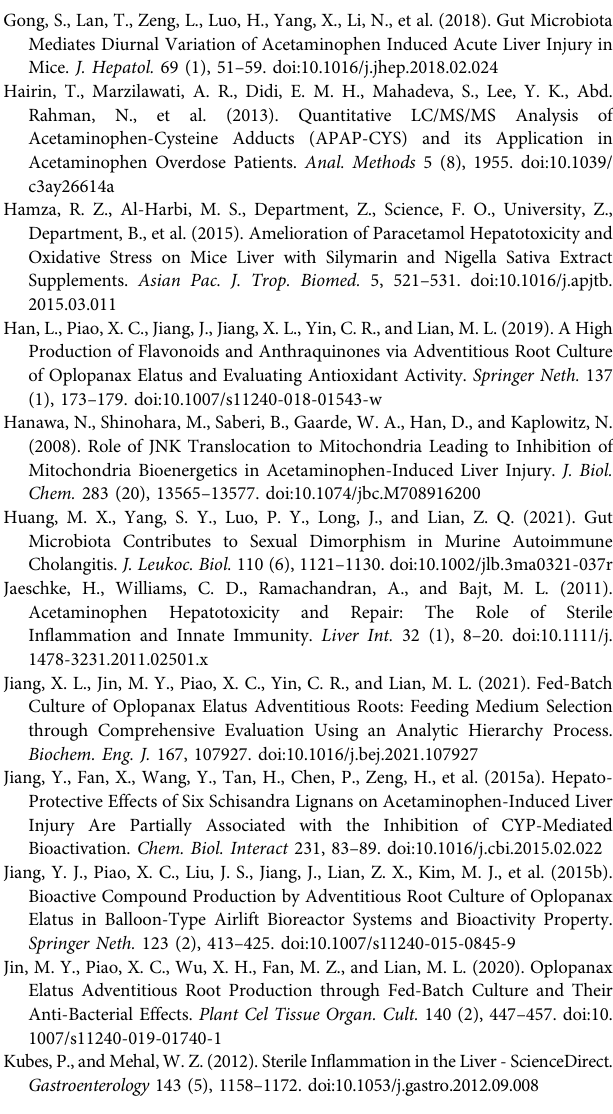
Supplementary Figure S1 | Extraction and separation of active compounds of OEB (A) Extract process of Oplopanax elatus . (B) HPLC pro fi le (UV chromatograms at 208 nm) of OECE, OEA, OEB, and OEC. The main compounds of OEB are chlorogenic acid and isochlorogenic acid A. Chromatography of authentic samples (C) chlorogenic acid and (D) isochlorogenic acid A. Supplementary Figure S2 | OEB pretreatment affected CYP450 and glucuronosyltransferase and sulfotransferase in vivo. (A) the mRNA expression of CYP2E1, (B) the mRNA expression of CYP3A11, (C) RNA-seq results of drug metabolism heatmap between OEB pretreatment group and APAP group. Supplementary Figure S3 | OEB pretreatment affected PPAR related gene expression in vivo. (A) Ppar α , (B) Fabp1, (C) Acaa1b and (D)